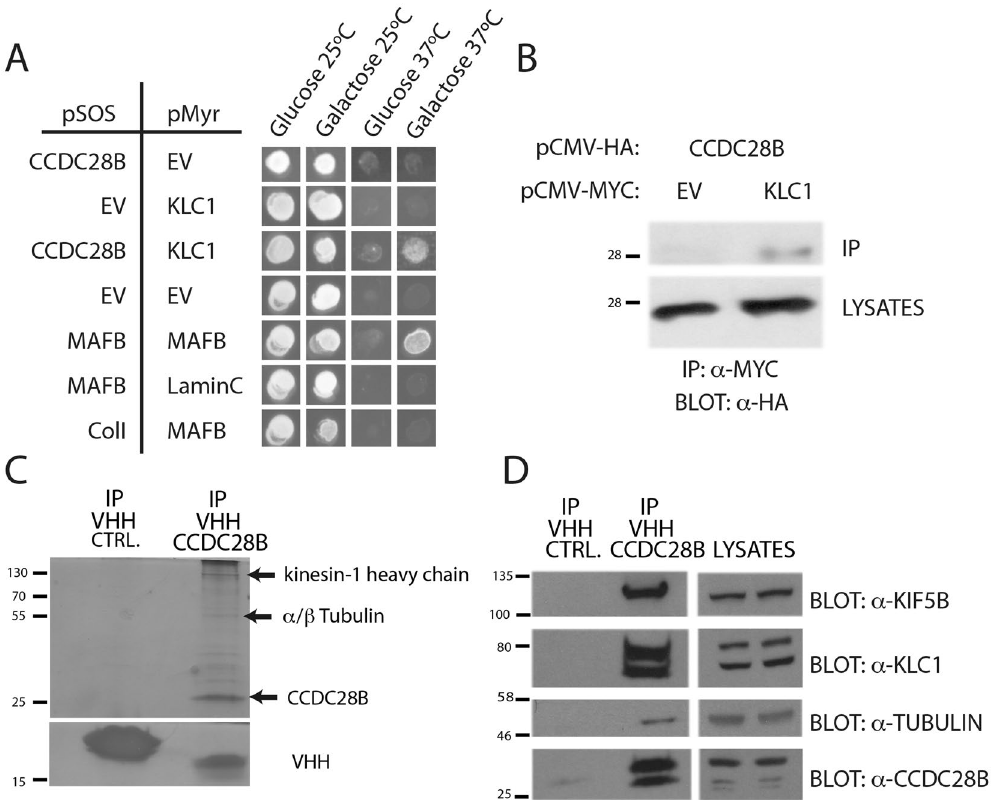
Figure 1. CCDC28B interacts with the kinesin 1 components KLC1 and KIF5B. ( A ) The co-expression of CCDC28B and KLC1 allows cdc25H yeast cells to grow at the non-permissive temperature of 37 °C only on galactose that triggers expression from the pMyr construct. Controls: MAFB-MAFB (positive); MAFB-Lamin C (negative), ColI-MAFB (negative), pSOS EV-pMyr EV (negative) and pSOS CCDC28B-pMyr EV (negative). ( B ) HA-CCDC28B is detected only in the Myc-KLC1 immunoprecipitate. Cell lysates are shown to control for protein input. Bands were cropped from the same blot which is shown in Fig. S2A. ( C ) Immunoprecipitation of overexpressed CCDC28B in Hek293 cells with the specific single domain llama antibody (VHH) results in the co-immunoprecipitation of additional proteins. Arrows indicate gel bands analyzed by mass spectrometry. An irrelevant VHH was used as control. The gel was cut in two to avoid saturation of the VHH bands when silver- staining the upper part of the gel. ( D ) The VHH against CCDC28B was used for immunoprecipitation and specific antibodies were used to detect KIF5B, KLC1, α -tubulin and CCDC28B. Cell lysates show the corresponding proteins in the extracts used for immunoprecipitation. Bands shown were cropped from the original blot. The full- length membrane was cut and exposed to the different antibodies (see Fig. S2B,C for blots and for